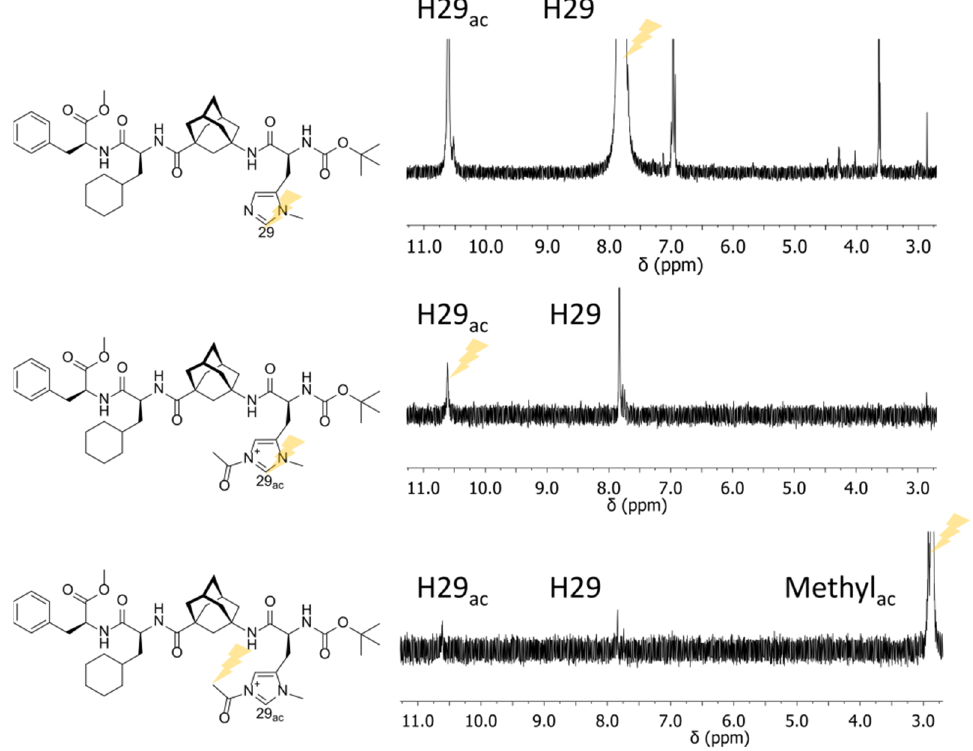
Figure 7. Selective 1 H − NOE spectra of tetrapeptide 1 , acetic anhydride 3 and acetylated tetrapeptide 6 in DCM − d 2 at − 20 °C (700 MHz 1 H frequency).